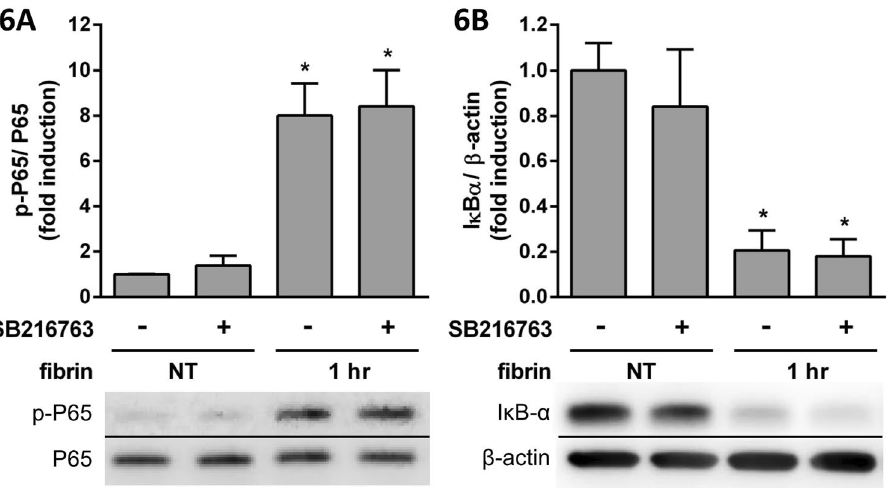
Figure 6. PMCs were overlaid with fibrin via incubation with a fibrinogen and thrombin mixture for 1 hr. The effects of SB216763 treatment on the expression of transduction factors were evaluated by Western blotting. The relative expression of ( A ) p-P65 vs. P65 and ( B ) I κ B α vs. β -actin are presented as a percentage of increase over untreated PMCs (NT). * P < 0.05 vs.